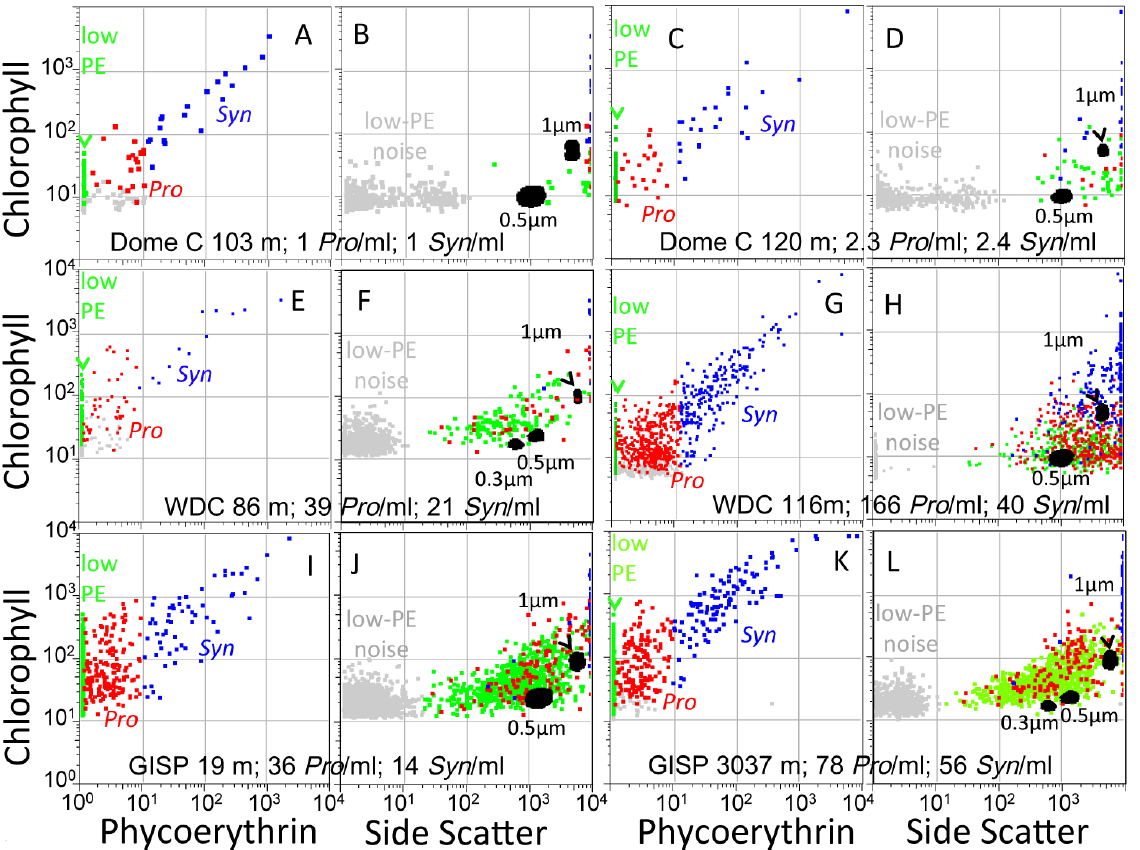
Fig. 7. Pairs of FCM plots of unstained cells, labelled with sites of ice cores, depths and concentrations of Pro -like and Syn -like cells. Dots are colour-coded for Pro -like cells (red), cells with very low PE (green) and Syn -like cells (blue). The gain on the Chl phototube was set higher for plots E, F , and I to L .